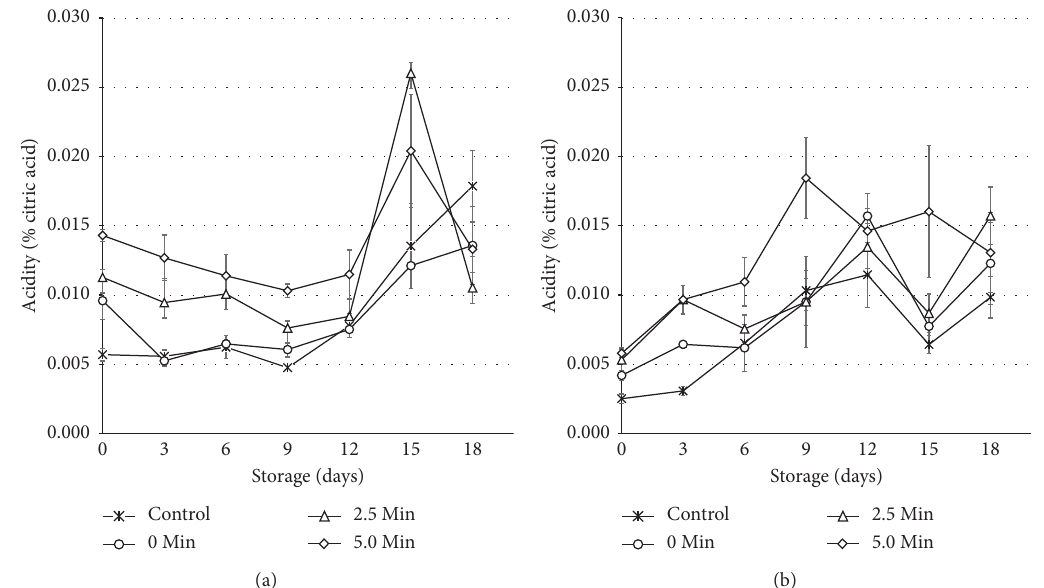
Figure 6: Immersion time effect on acidity during storage of papaya cubes. Control (a) and E coli treated cubes